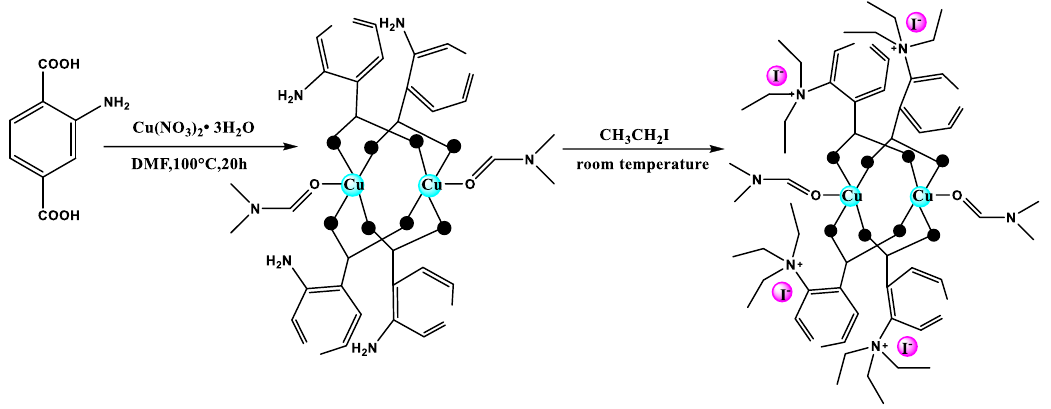
Table 8. The reaction yield from Cu(BDC-NH 2 )(DMF) to Et- N -Cu(BDC-NH 2 )(DMF).